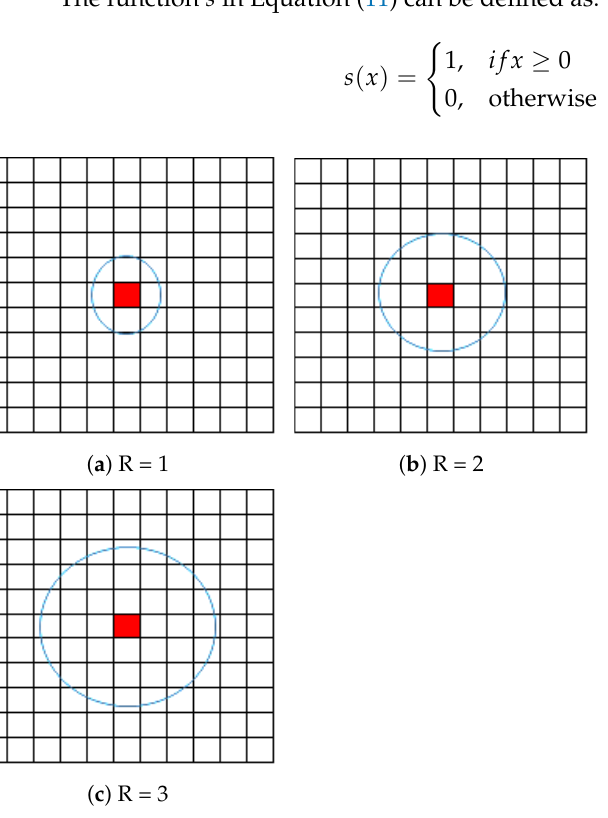
Figure 3. The radius (R) and its corresponding